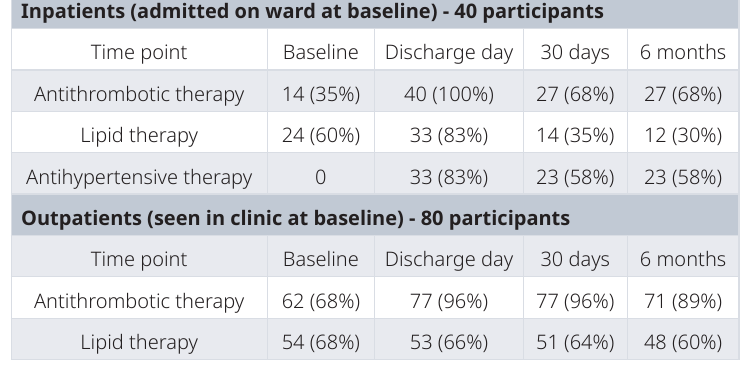
Table 4. Pharmacotherapy prescribed per National Institute for Health and Care Excellence (NICE) guidance before the patients took part in the study, at baseline (i.e. once they left clinic or they went home for those who were inpatients) and at 6 months, as well as biochemistry and relevant cardiovascular risk factors.